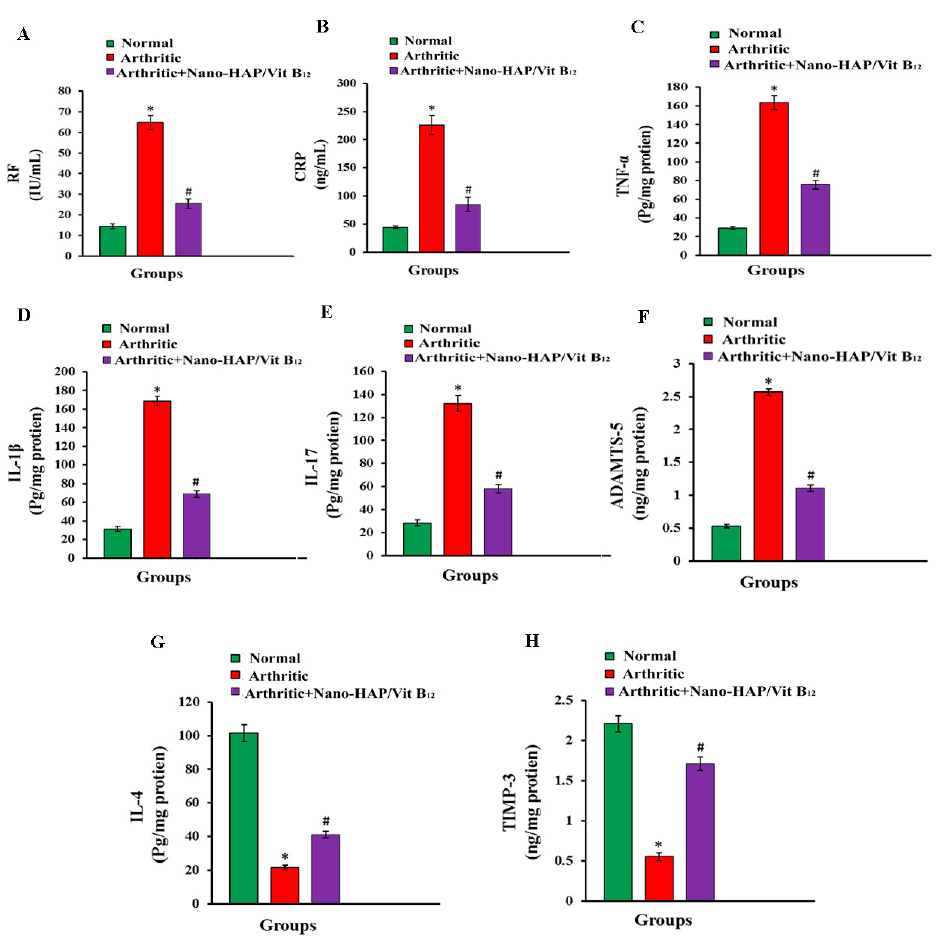
Figure 7. Effects of nano HAP/Vit B 12 on serum levels of: ( A ) RF; ( B ) CRP; ( C ) TNF- α ; ( D ) IL-1 β ; ( E ) IL-17; ( F ) ADAMTS-5; ( G ) IL-4; ( H ) TIMP-3 (Data are expressed as mean values ± SEM, (* p < 0.05: significant difference relative to arthritic rats, # p < 0.05: significant difference relative to arthritic rats treated with Nano-HAP/Vit B 12 ).